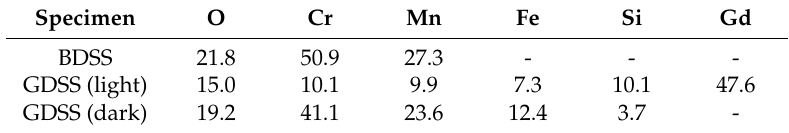
Table 2. Quantitative chemical composition of the inclusions in each BDSS characterized by EDS (wt. %). Specimen